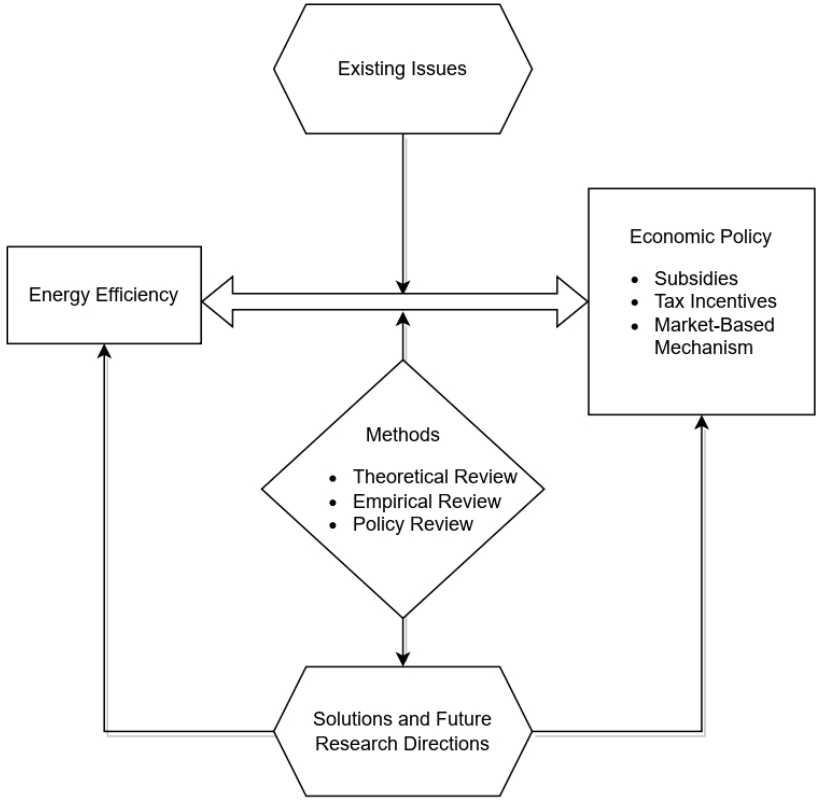
Figure 2. Framework of the study. Source: Own